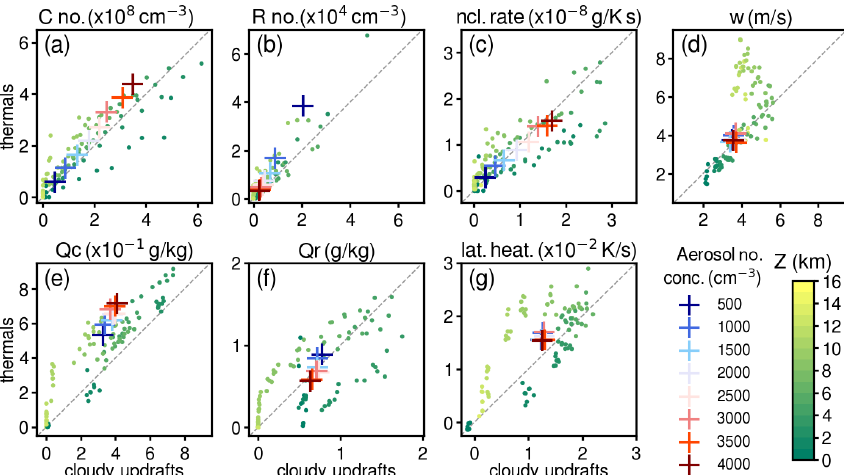
Figure 7. Scatterplots of (a) cloud drop number concentrations (C no.), (b) rain number concentrations (R no.), (c) cloud nucleation rates, (d) vertical velocity ( w ), (e) cloud water mixing ratio (Qc), (f) rain water mixing ratio (Qr), and (g) latent heating rates, as obtained from averaging over thermals (vertical axis) and over cloudy updraft grid points (horizontal axis). Averages over thermals are computed by first obtaining an average value for each thermal and then averaging over all thermals at a certain altitude range (colored dots) or averaging over all thermals (crosses; colors according to aerosol number concentration of each experiment). Values for cloudy updraft grid points are obtained by averaging these per altitude range (colored dots) or per experiment